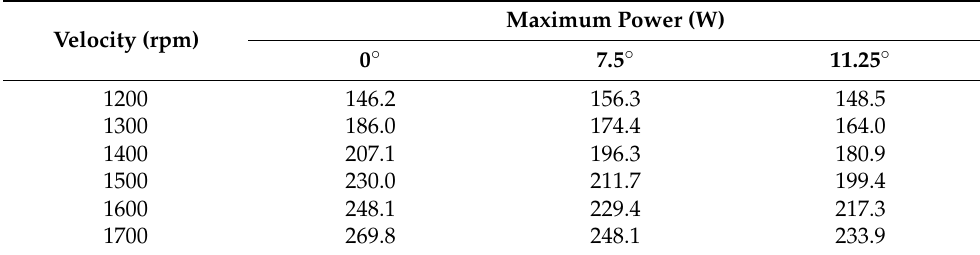
Table 5. Maximum power at different velocities and angles.